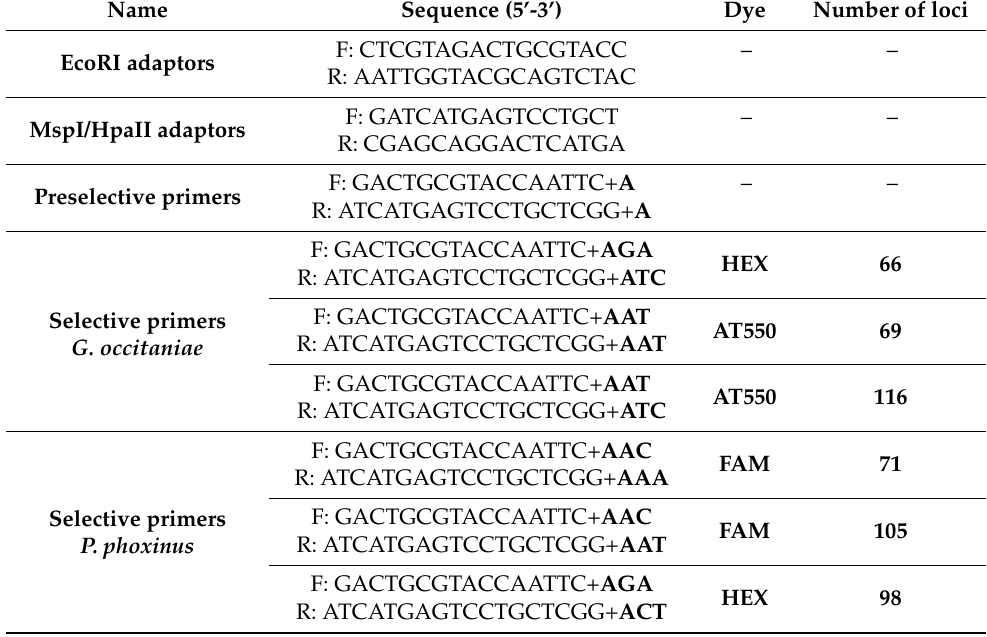
Table A2. Sequences of adaptors and primers used in the Methylation-Sensitive-Amplified Fragment Length Polymorphism (MS-AFLP) protocol (and their dyes and the number of loci per primer). Forward (F) and Reverse (R) strand. The same preselective primer was used for both species and three different selective primers were used for each